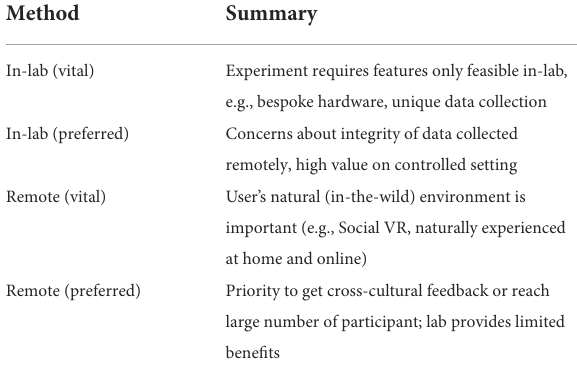
TABLE 1 Summary of XR study sub-types.